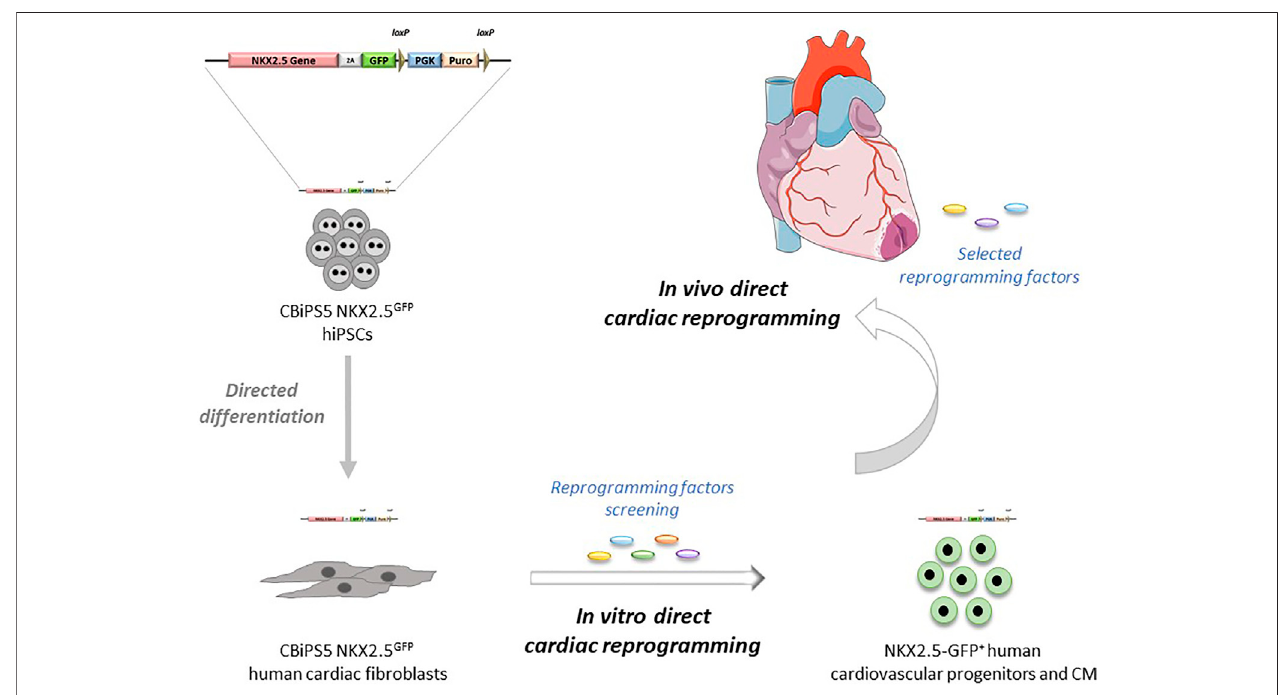
FIGURE 5 | Potential applications of NKX2.5 GFP reporter cell lines in direct cardiac reprogramming.